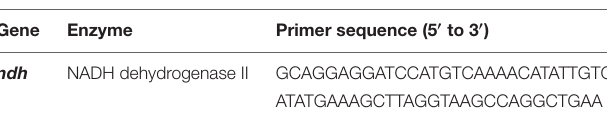
TABLE 1 | List of primers used in the study. For cloning and expression of ndh gene Gene